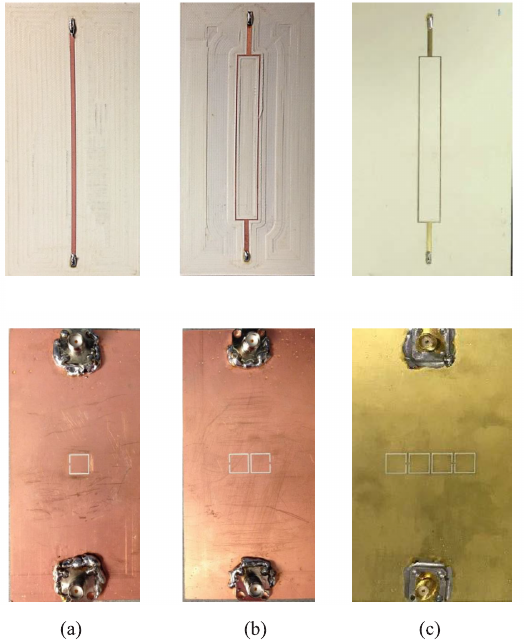
Figure 7. The top and bottom views of the fabricated 1CSRR ( a ), 2CSRR ( b ) and 4CSRR ( c ) sensors. Reprinted with permission from Ref.